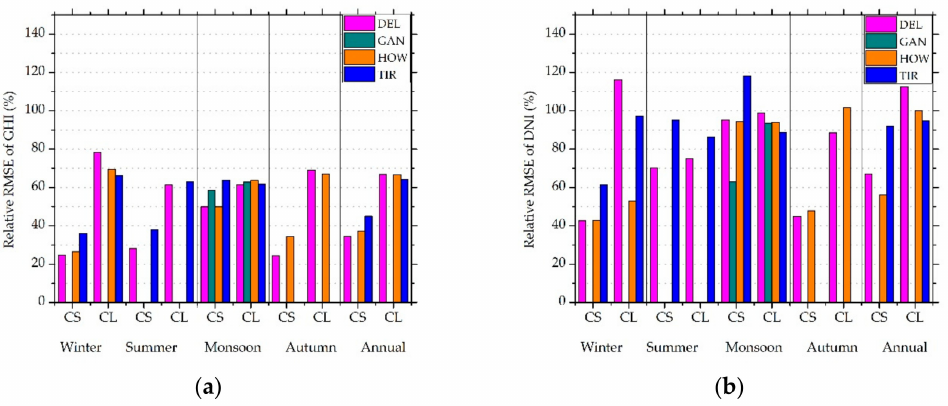
Figure 6. Seasonal relative root mean square error (rRMSE) values of ( a ) GHI and ( b ) DNI estimations from RTM simulations and INSIOS technique, as compared to BSRN measurements.